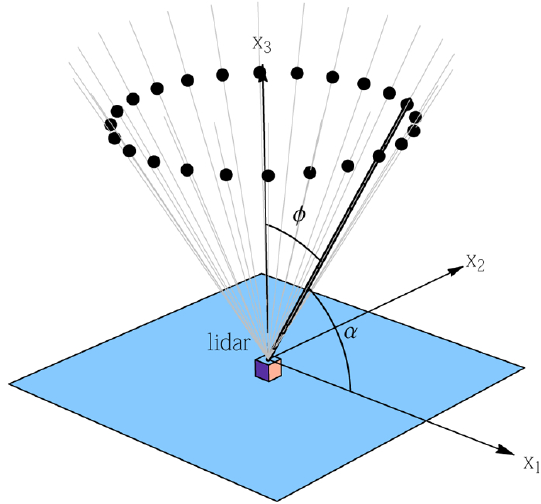
Fig. 2. Schematic of the lidar operating in a VAD scanning mode.